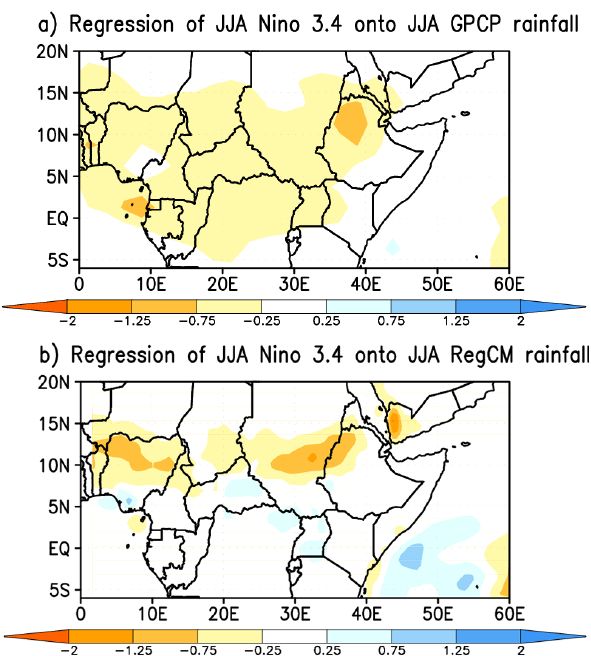
Figure 14. As Fig. 13 but for the Sahel and equatorial Africa region: (a) GPCP; (b) Reg-TB ensemble